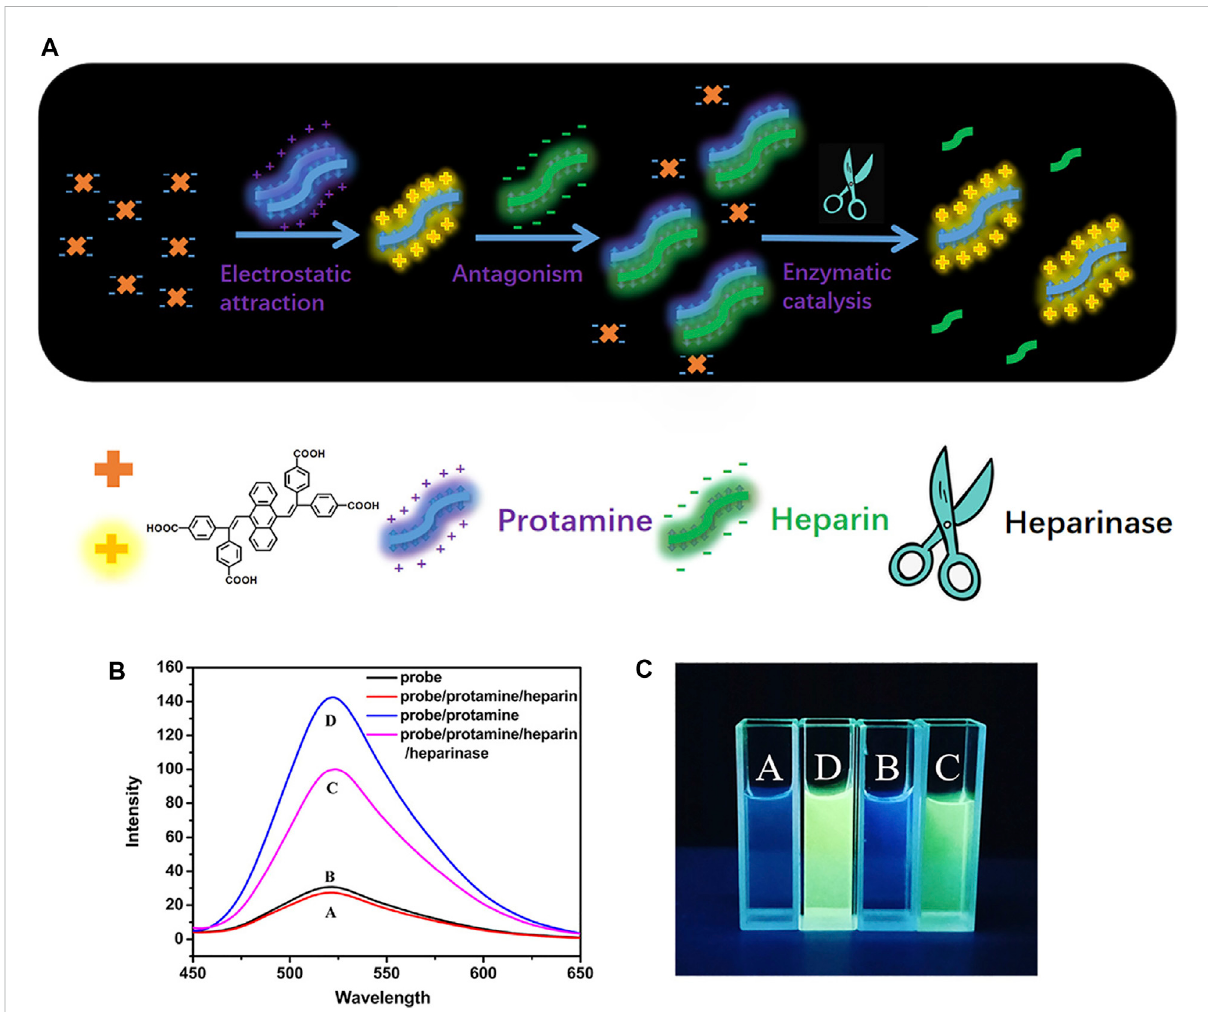
FIGURE 10 (A) Self-assembly of the copolymer (HSP-TPE) containing fl uorescent TPE probe and sensing behavior of HSP-TPE aggregates toward picric acid (PA); (B) fl uorescence spectra of DSA-4COOH, DSA-4COOH/PRO/HEP complex, DSA-4COOH/PRO/HEP/heparinase complex, and